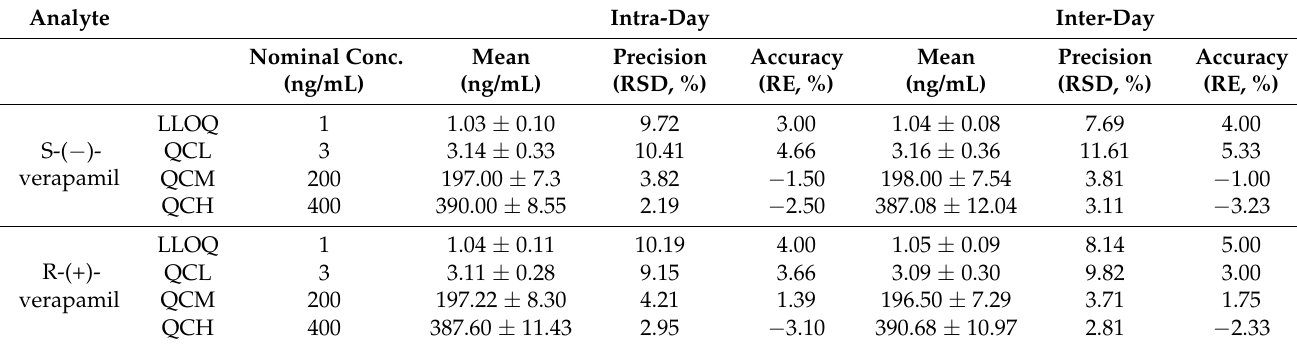
Table 4. Precision and accuracy data for analysis of verapamil enantiomers in rat plasma (3 days with 6 replicates per day). Analyte